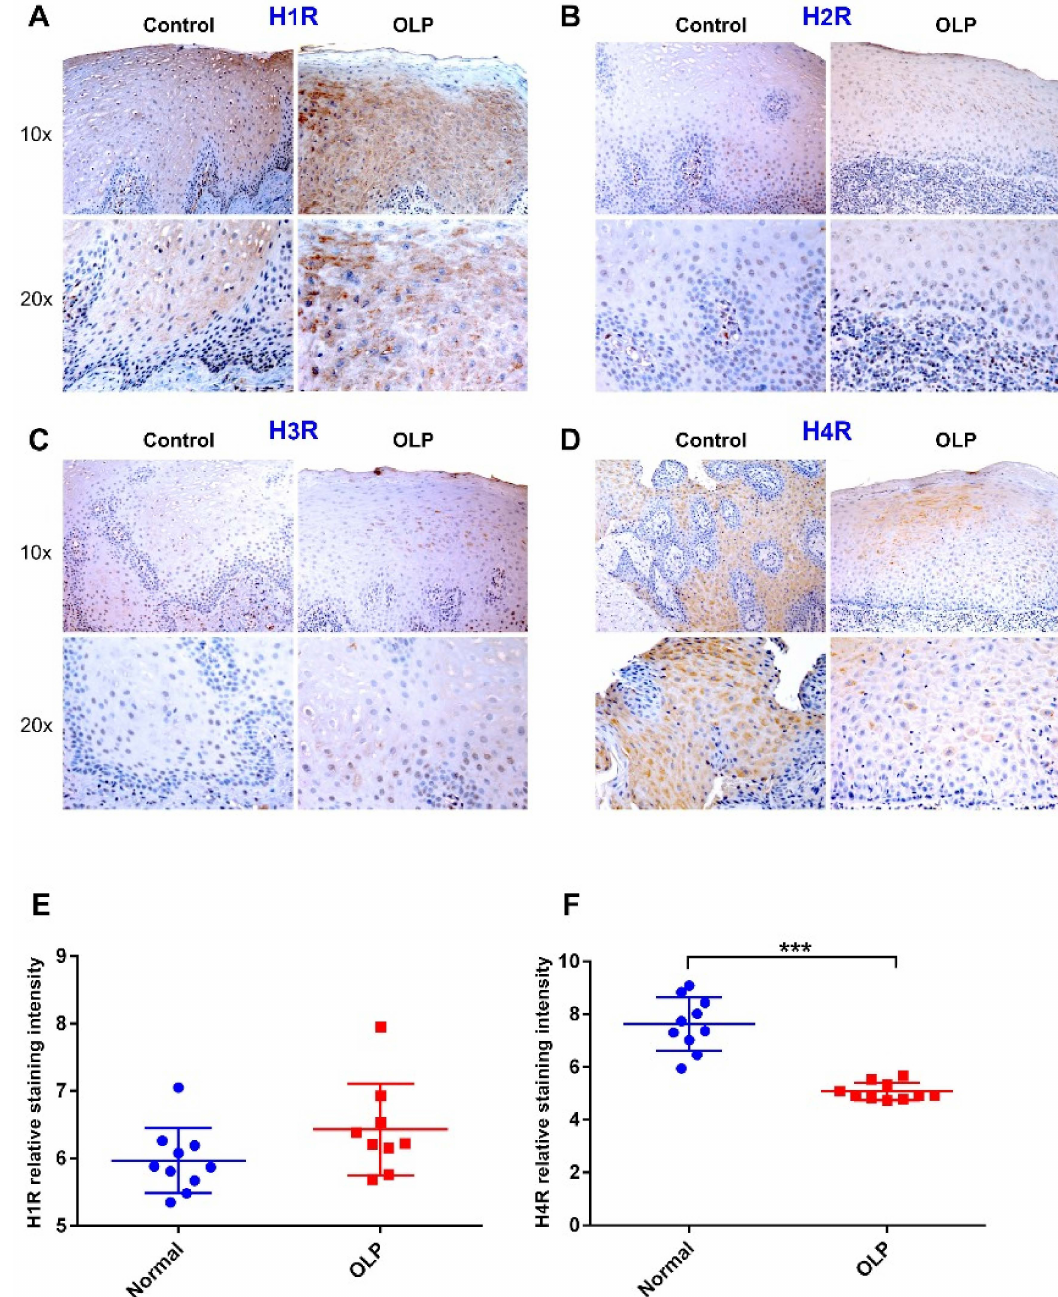
Figure 4. ( A ) Immunostaining assays showed strong expression of histamine receptor 1 (H1R) in normal epithelium and in OLP lesions. ( B , C ) H2R and H3R staining were very faint in both normal and OLP specimens. ( D ) In contrast, H4R was strongly expressed in normal controls compared with the markedly weakened expression in OLP lesions. The staining shows that H1R and H4R were expressed mainly in the cytoplasm and cell membranes of epithelial cells. ( E , F ) ImageJ analysis demonstrated almost equal expression of H1R in control and OLP samples, while expression of H4R was very low in OLP lesions. Data are expressed as means ± SD; n = 10 for controls and OLP groups; *** p ≤ 0.0001. Mann–Whitney U test was